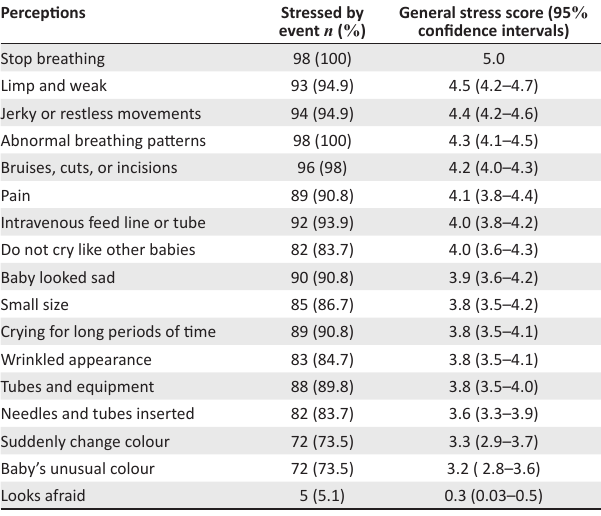
TABLE 1: Parents’ perception of how their babies appeared and behaved ( n = 98).